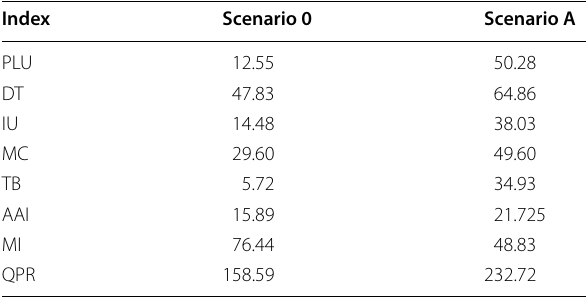
Table 2 Penetration rate according to calculated